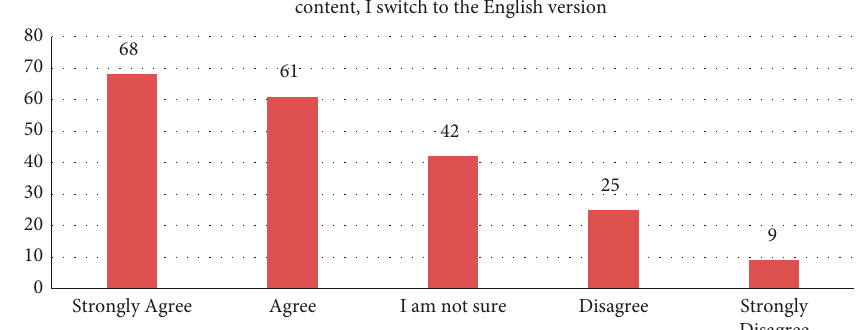
Figure 7: Participants’ responses regarding the idea of switching to the English version of Amazon.sa in case of having difficulties.